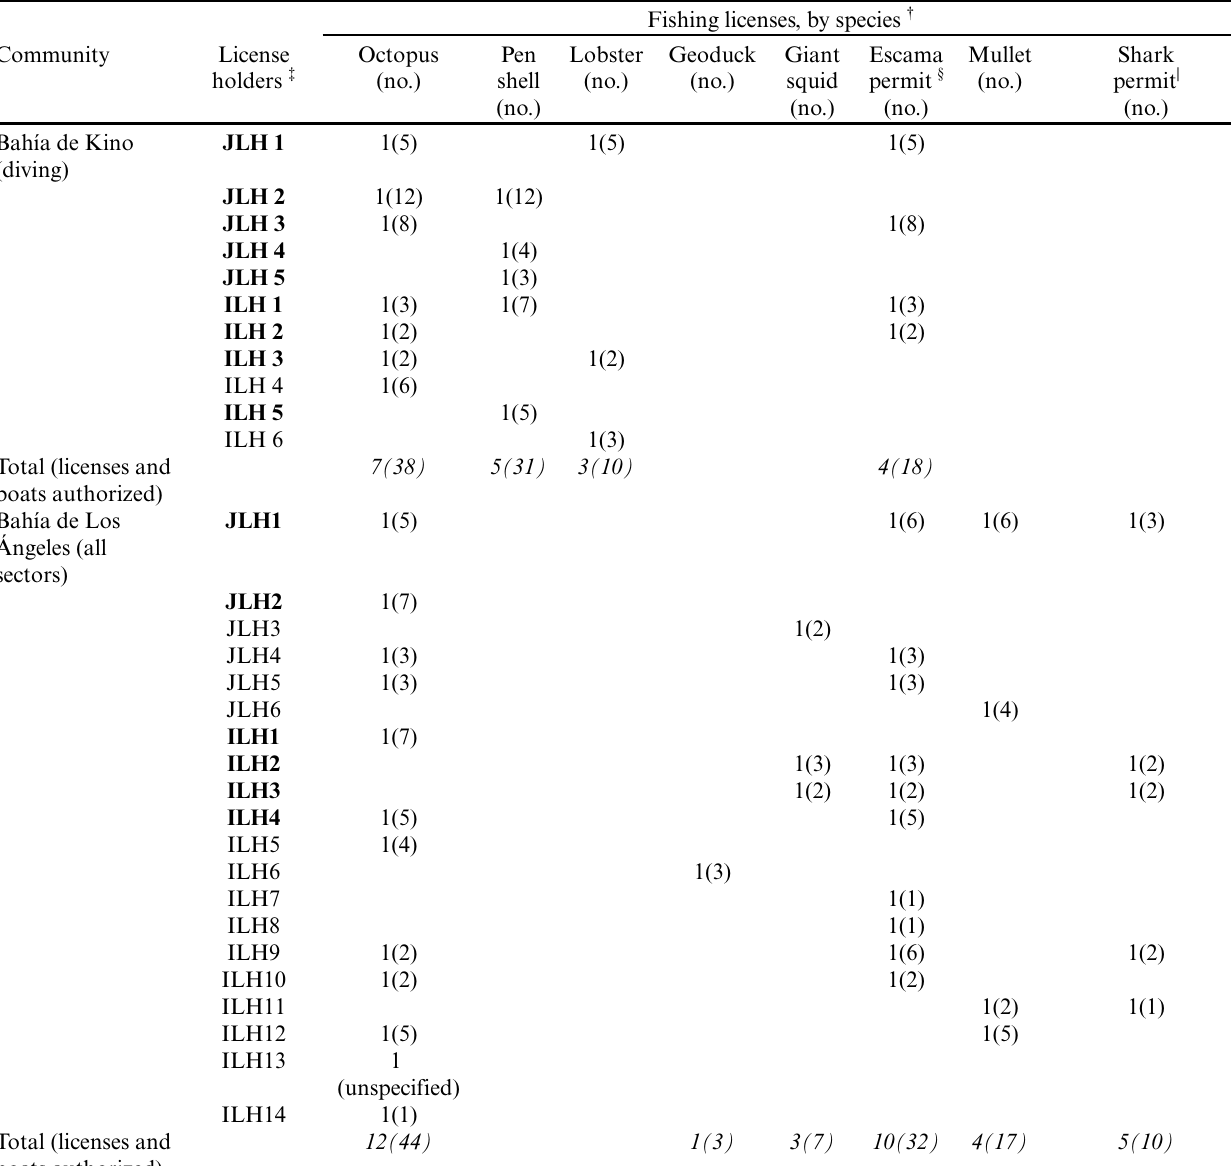
Table 3 . License holders with permission to operate in Bahía de Los Ángeles in 2008—2009 (all fishing sectors) and in Bahía de Kino in 2007—2008 (for four main target species of commercial diving). Data source: Comisión Nacional de Acuacultura y Pesca